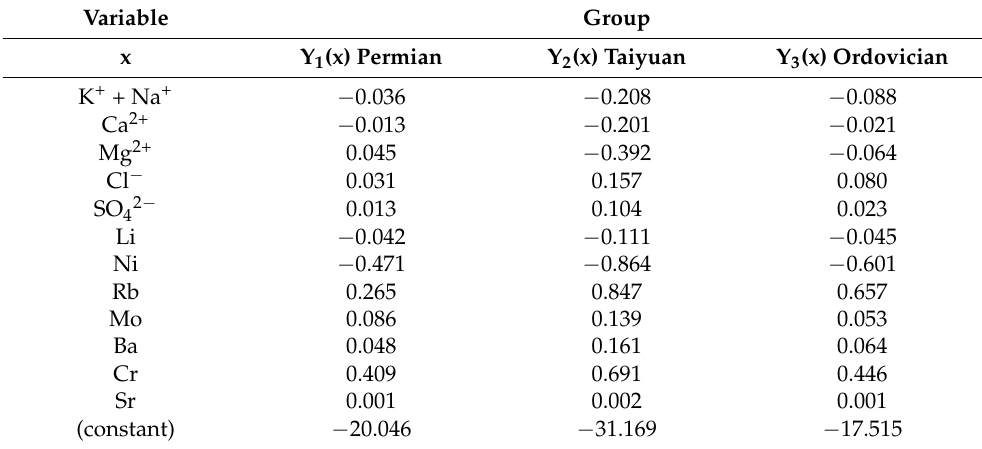
Table 12. Modified Bayes multi-class LDA function coefficient (C 0g , C 1g , C 2g , . . . , C pg )